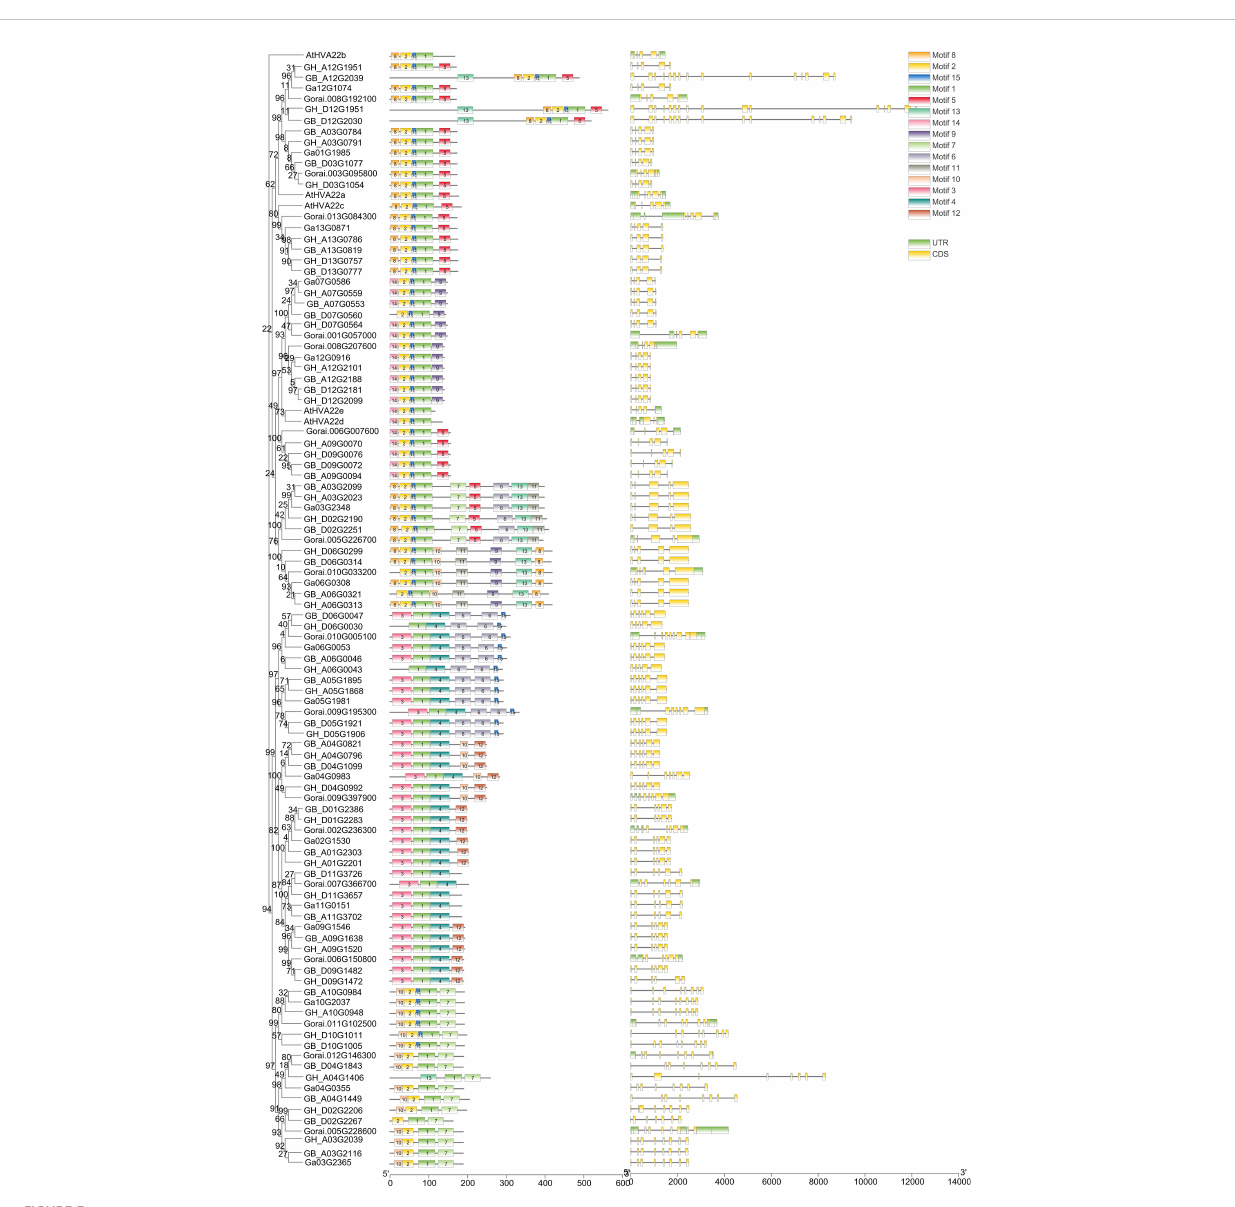
FIGURE 3 Gene structure and conserved motif of HVA22s in G. hirsutum, G. barbadense, G. arboreum, G. raimondii, and A.